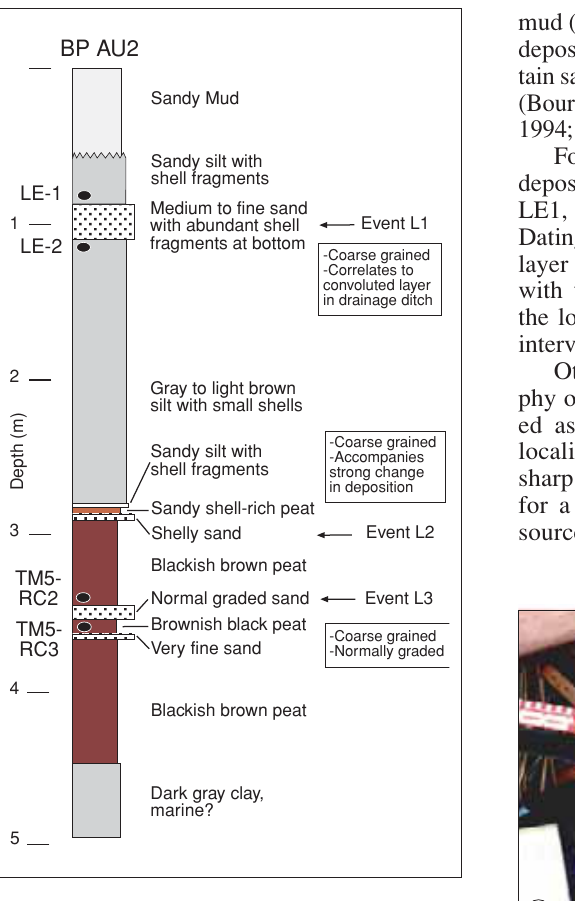
Fig. 8. Core BPAU2 log from Lesina Lake area. The location of four charcoal samples is also plotted with a black